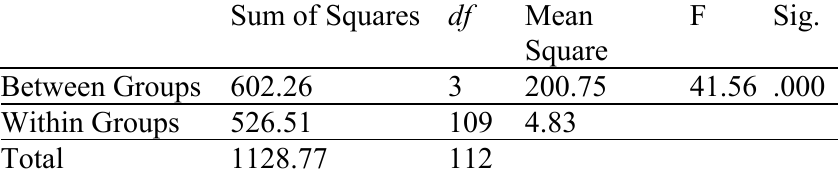
One-Way ANOVA Results of Recognition by Groups Sum of